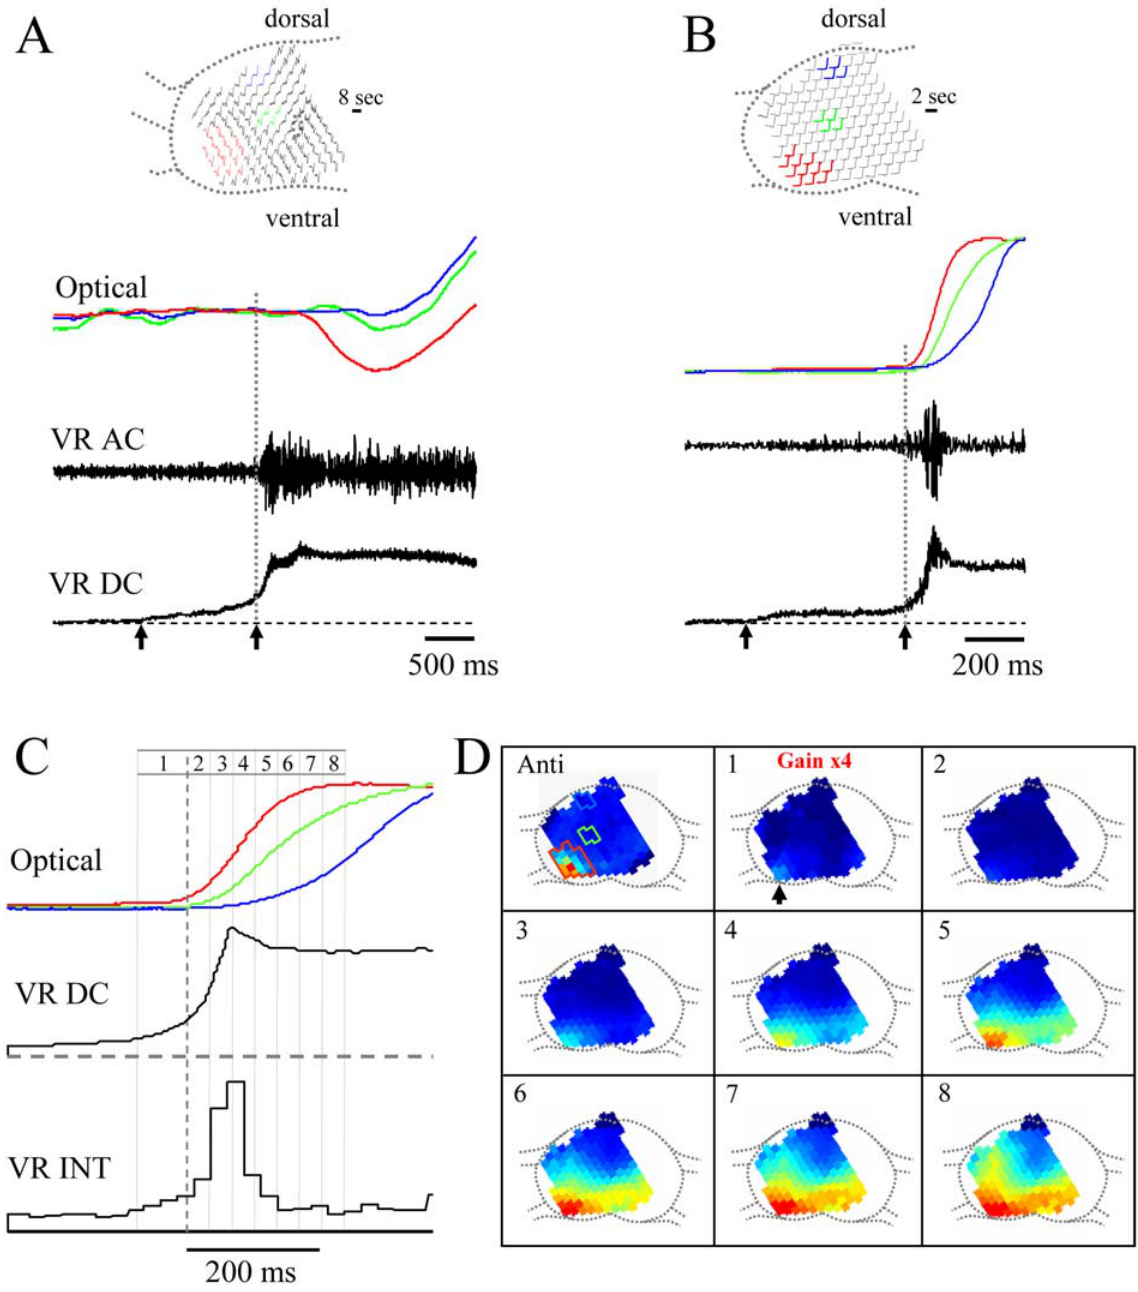
Figure 4. Optical signals originate ventrolaterally at the onset of a spontaneous episode. Both intrinsic (A) and dye-related (B) optical signals originate over the motor column at the onset of a spontaneous episode. Each optical signal was spatially averaged from the diodes shown in the schematic of the cord above the traces and then normalized to its peak amplitude. The electrical activity was simultaneously recorded from the ipsilateral ventral root (VR). DC-unfiltered. AC-band pass filtered from 20-312Hz. The arrows delineate the initial slow rise of the depolarization and the onset of discharge (dotted gray line) in the ventral root. Data in A were obtained from an E9 embryo, while those in B were from an E10 embryo. C. Spread of dye-related activity at the beginning of a spontaneously occurring episode. The data were averaged from two E10 embryos and synchronized to the onset of the ventral root discharge (dotted gray line). The smoothed DC ventral root potential (VR DC) and the integrated ventral root discharge (VR INT-25ms integration time) are displayed together with the optical responses from three different cord regions (ventral/lateral motor column-red; intermediate-green; dorsal-blue). Each record was averaged from several adjacent diodes (shown in panel A of the montage illustrated in D) and normalized to its peak amplitude. Data were obtained at a sampling interval of 0.64ms. The gray lines over the traces in C, delineate the frames that were averaged to produce the pseudocolored montage. D. Montage of the pseudocolored diode array signals superimposed on the outline of the transverse face of the cord slice. The number in each panel corresponds to the numbered intervals over the electrical and optical traces. The first image (Anti) in the sequence is a pseudocolored image of the optical signals during antidromic stimulation of the ipsilateral ventral root to identify the location of the lateral motor column. The colored regions on the image identify the location of the diodes whose signals were averaged to produce the optical records in C. The second image (1, Gain 6 4) was obtained before the onset of discharge (vertical dotted gray line in C) and was averaged from 105 frames (67ms/frame) is displayed at 4 6 the gain of the remaining images. All remaining images (2– 8) were averaged from 45 frames (29ms/frame). The arrow shows the earliest detectable activity occurs over the lateral motor column. doi:10.1371/journal.pone.0000417.g004 PLoS ONE |